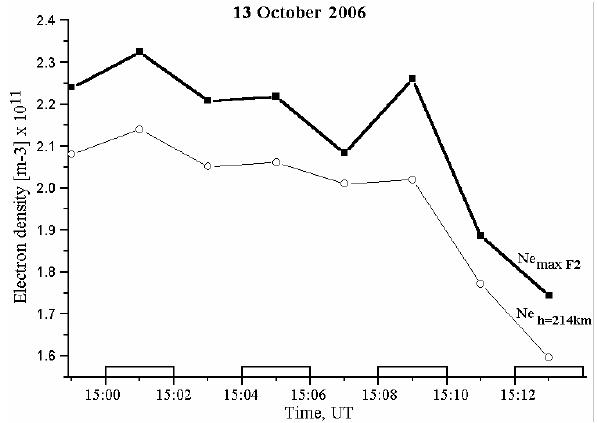
Fig. 9 Fig. 9. Temporal variations of electron density from the maximum of the F2 layer, and from 214km estimated from N e (h) profiles obtained from Tromsø dynasonde data on 13 October 2006 from 14:58 to